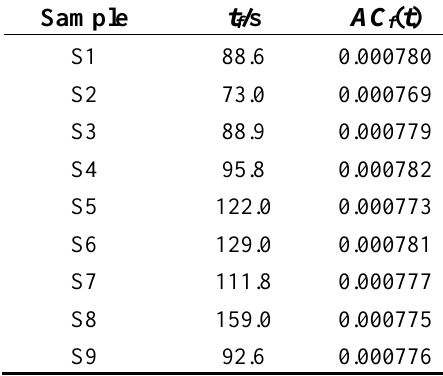
Table 2. The results of characteristic parameter AC ( t ) and duration of the elastic stage t f